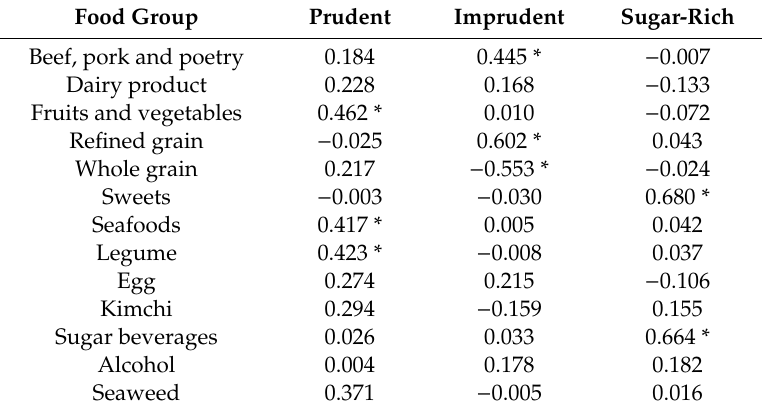
Table 2. Principal components analysis. Varimax-rotated food group factor loading scores for dietary intake of study participants .